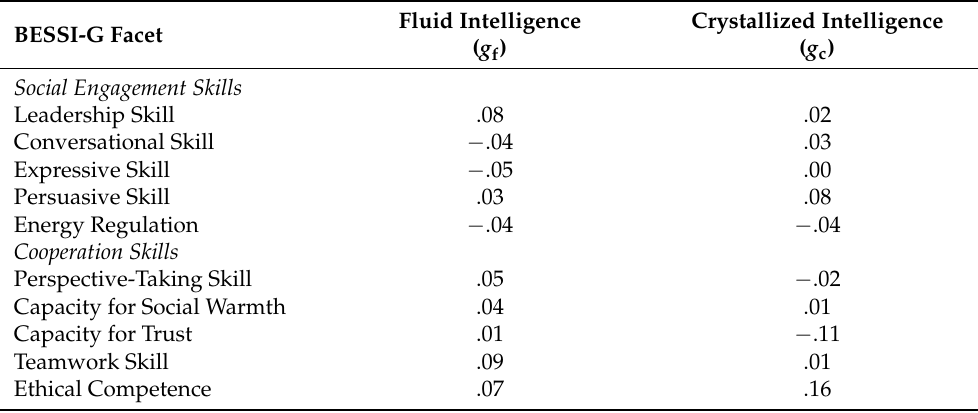
Table 8. Correlations of the BESSI-G facets with cognitive ability (Study